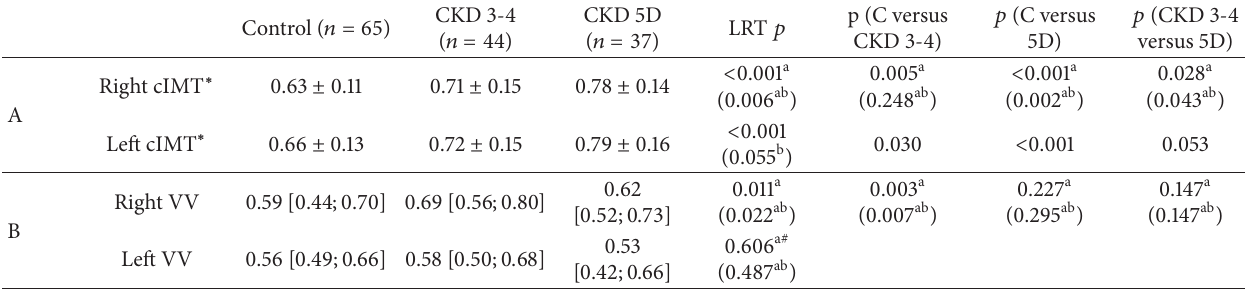
Table 2: Carotid IMT and carotid adventitial VV values in control subjects and patients affected by chronic kidney